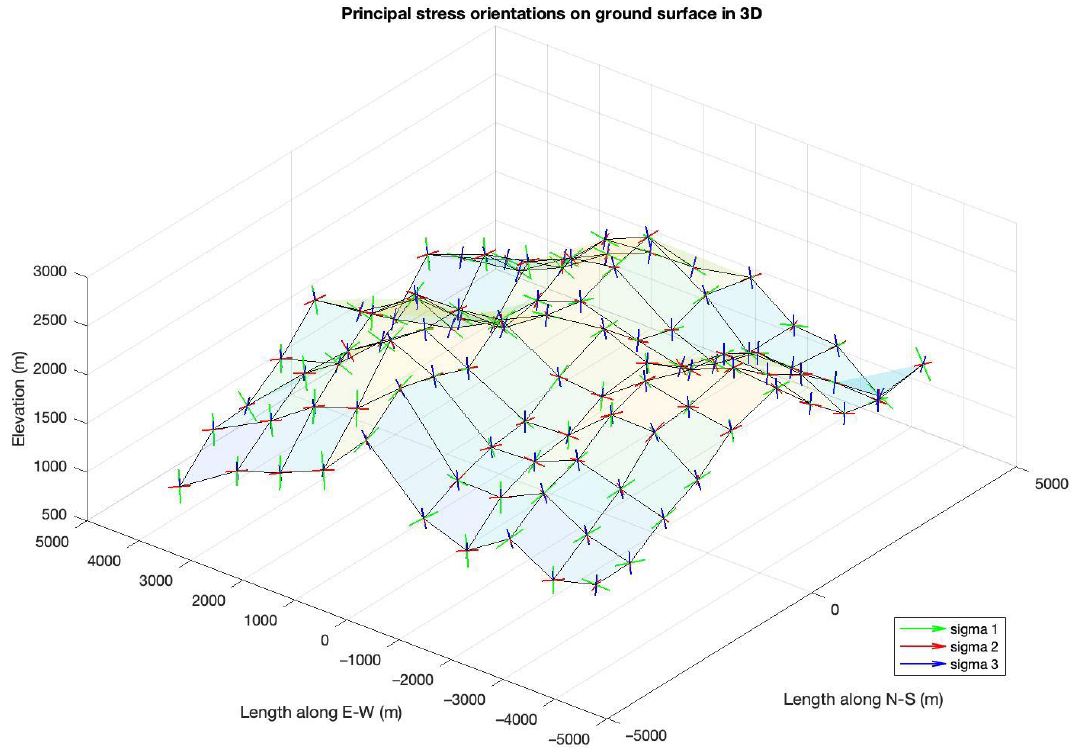
Figure 6. Principal stress directions on the surface in 3D, applicable to both cases with and without the implementation of tectonic stresses.